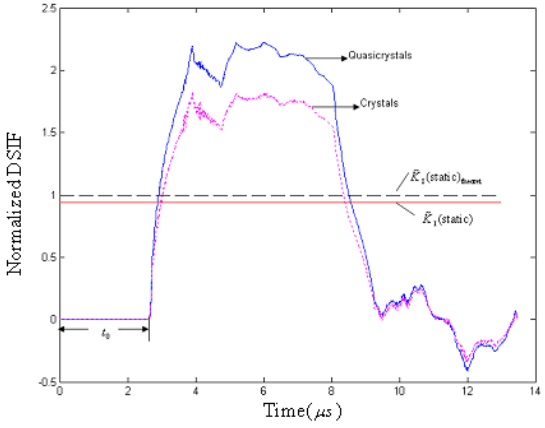
Figure 8. Variations of with